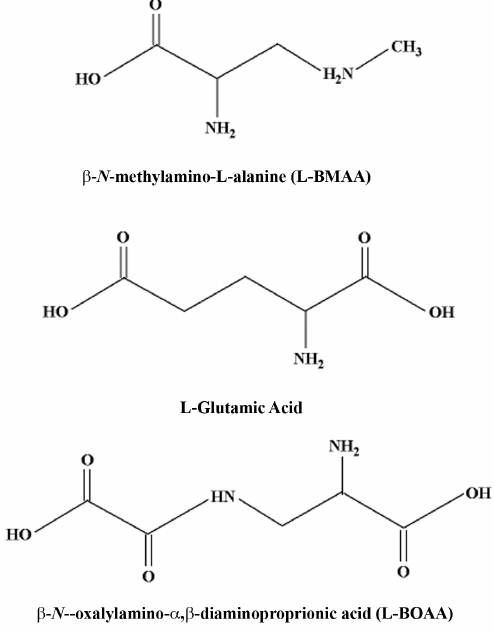
Figure 3. Structures of the amino acid neurotransmitter L-glutamate and the excitotoxic amino acids  - N -methylamino-L-alanine (L-BMAA) and  N -oxalylamino-L-alanine (L-BOAA). Note the structural similarity between glutamate and both L-BMAA and